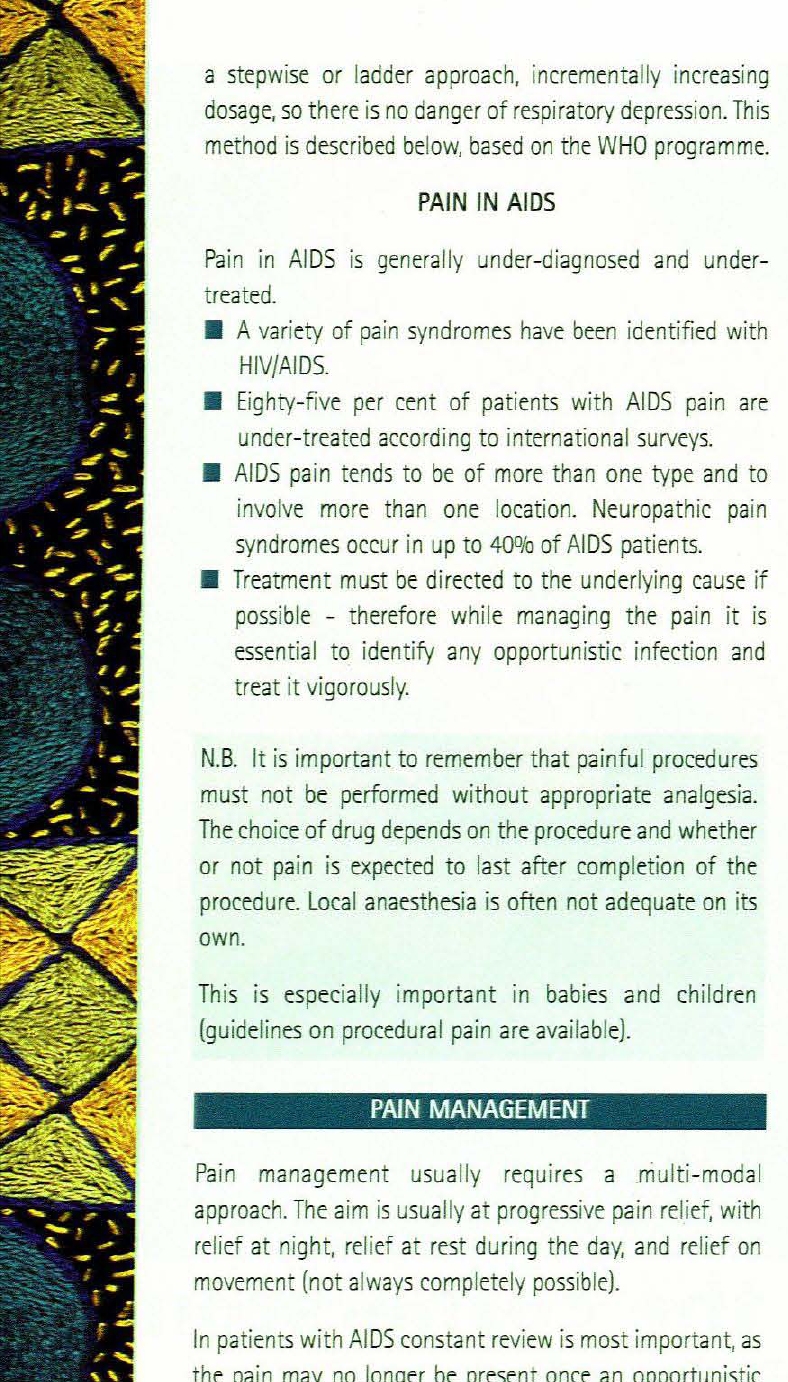
Children: Faces scale: The child chooses the